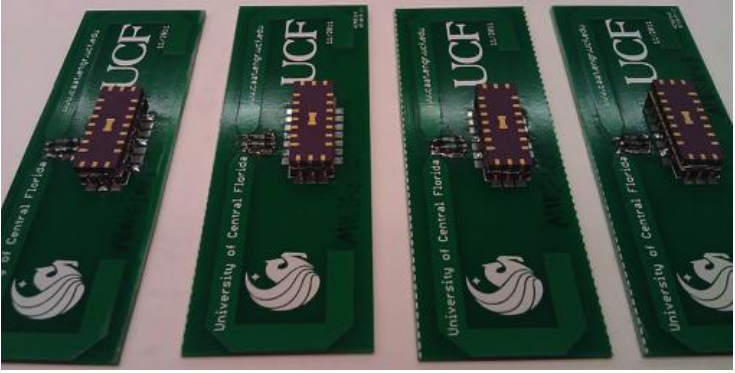
Figure 19. Photo of four packaged 915 MHz OFC closure sensors with PCB antenna. The sensors use miniature REED switches as the magnetic sensing element, seen between the folded dipole antenna and the top of the surface mount package. Open and close setting is determined by a change in the received amplitude of the device. This embodiment demonstrates that the SAW can be used as the communication link when integrated with external ―off-board